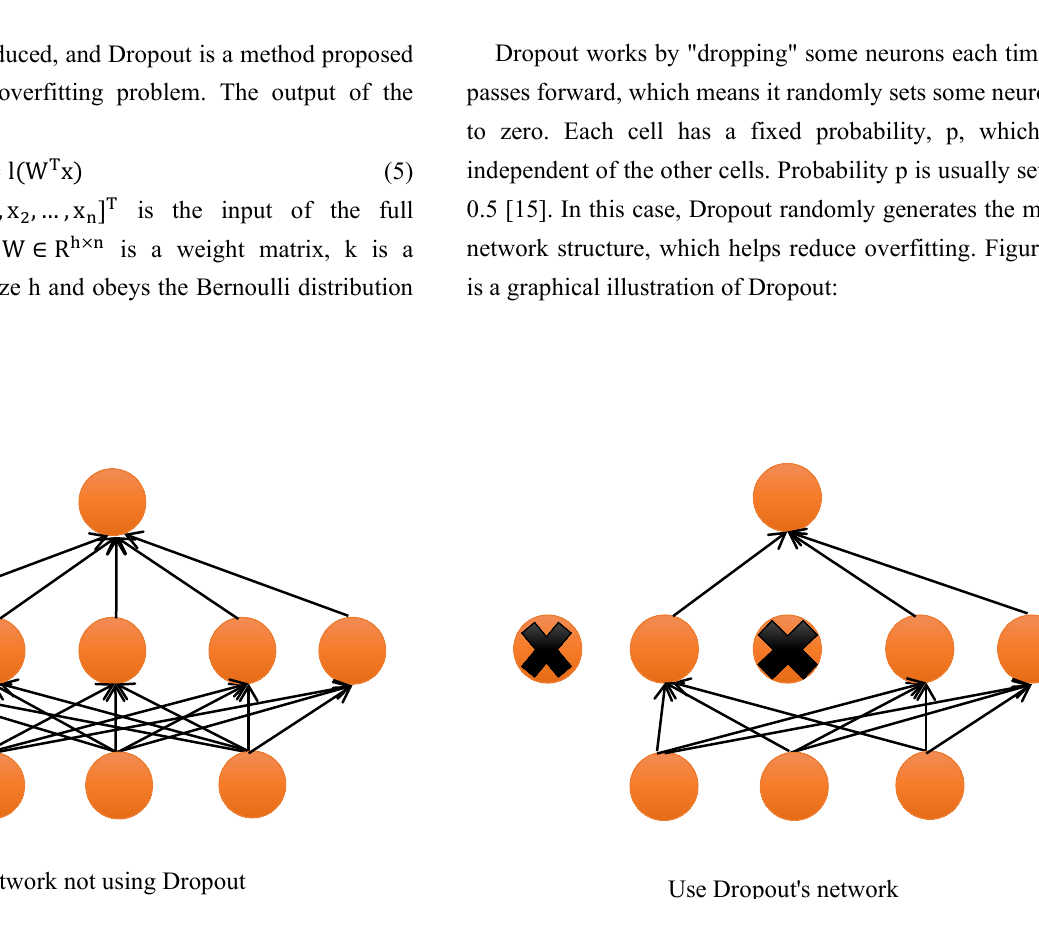
Figure 5. Dropout